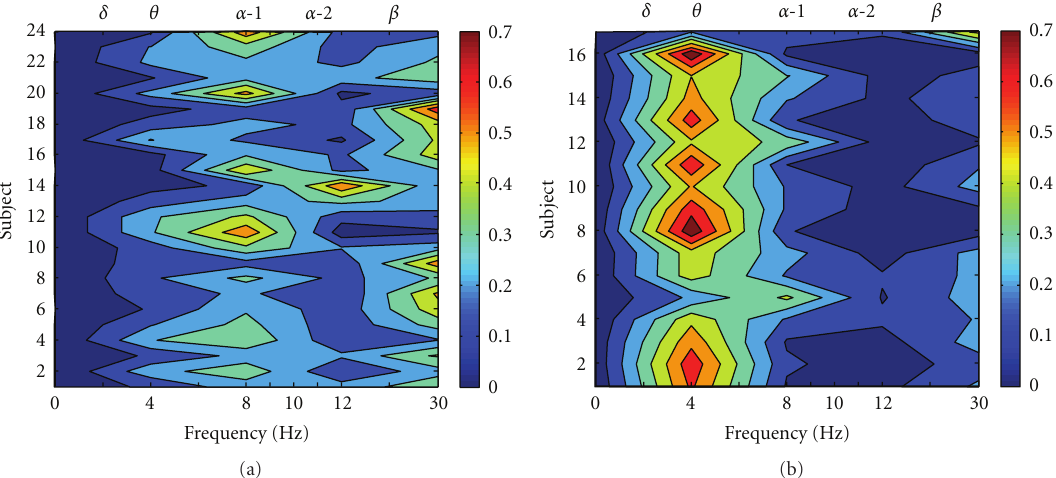
Figure 5: Relative power distribution in various frequency bands for all the datasets. (a)Control group. (b) Mild Alzheimer’s disease subjects.